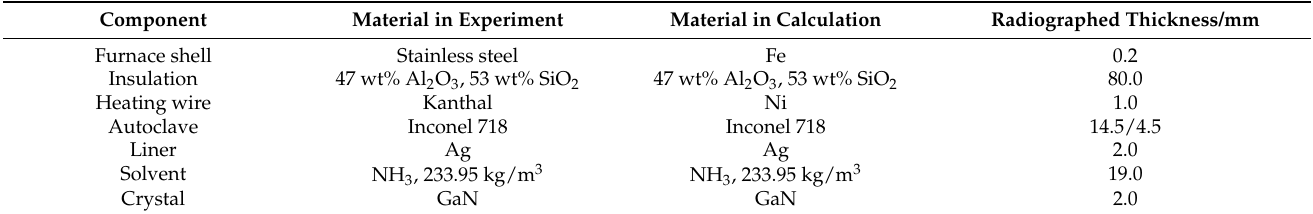
Figure 2. Calculated X-ray transmission of Inconel 718 for different values of the wall thickness t (i.e., a radiographed thickness of 2 t ) as a function of photon energy.